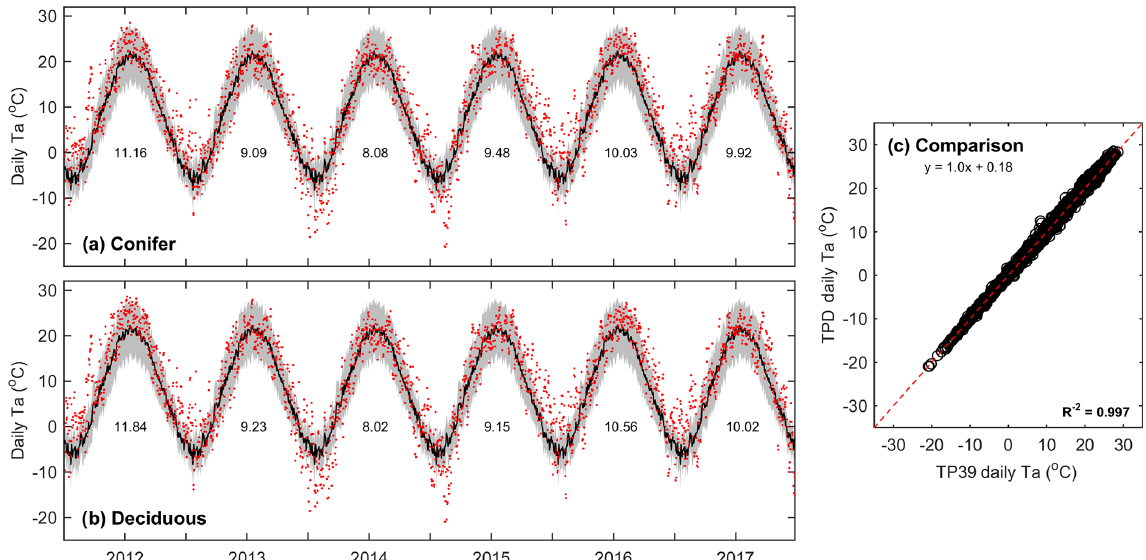
Figure 1. Daily above-canopy air temperature ( T a , red dots) measured from 2012 to 2017 at the (a) conifer forest (TP39) and (b) deciduous forest (TPD), with the grey shading and black line corresponding to the 30-year Environment Canada (Delhi station) minimum and maximum range of daily T a and mean daily T a , respectively. Values shown represent the annual mean T a for each year of measurements. Also included is the (c) comparison of daily T a at TP39 and